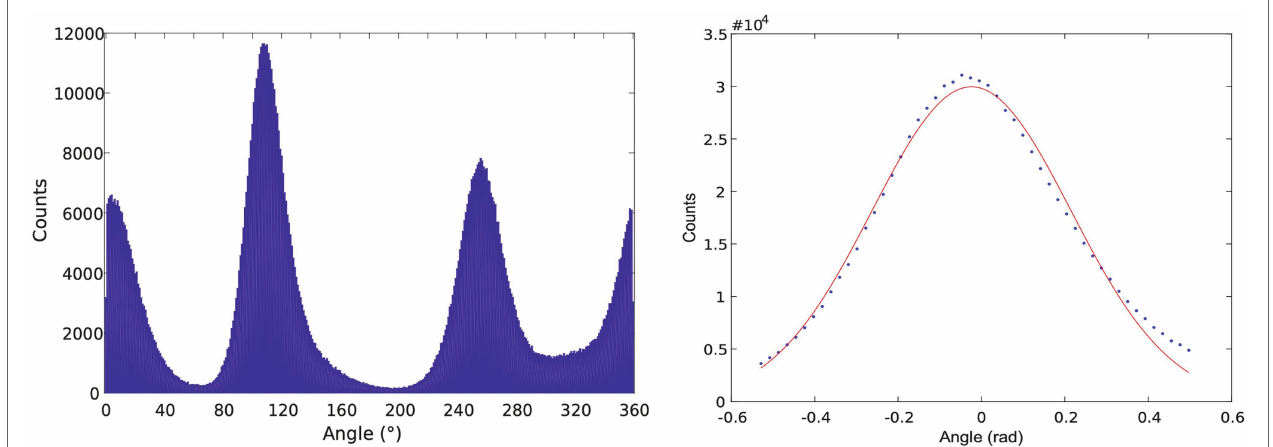
FIGURE 6 | Left: Histogram of angular positions in the dwells from ThF1 rotation trajectories. Right: Consolidated histogram of all three subunits after selecting for “high-quality” dwells. More recently, a correction method was developed for treating the asymmetry between subunits using a tilting algorithm. The figure was reproduced from Volkán-Kacsó et al.